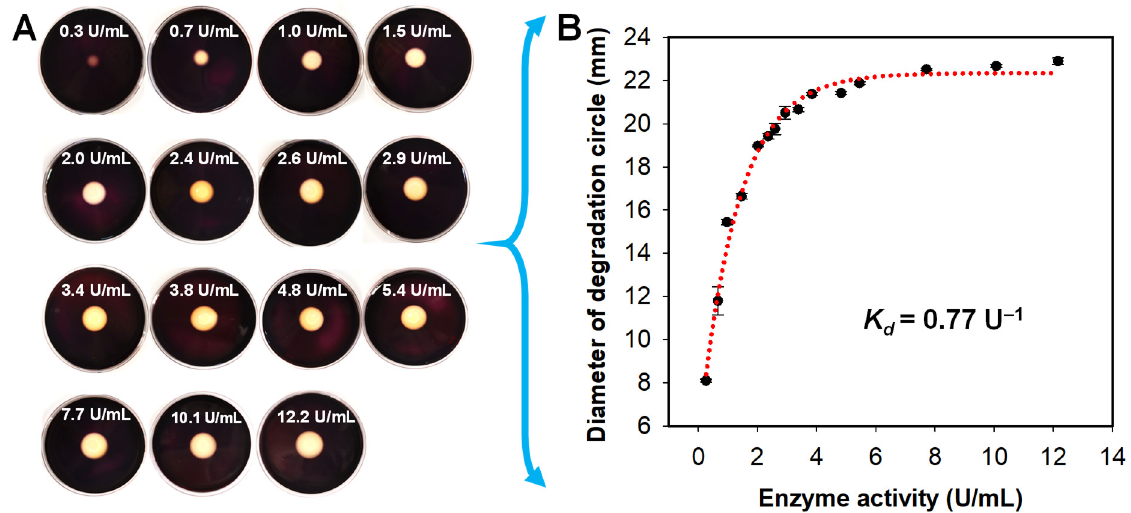
Figure 4. The agar-degrading capacities of agarase secreted by A. macleodii QZ9-9. ( A ) Characteriza- tion of agar-degrading activity of crude agarase with different enzyme activities on the mineral salts agar plates (stained with Lugol’s iodine solution). ( B ) Kinetics of agar degradation by agarase. Note: The data were fitted according to the first-order rate equation Y EA = Y 0 + a(1 − e − kx ), where Y EA and Y 0 are the degradation fraction at a given enzyme activity EA and 0 U/mL, respectively; a is the fitting coefficients; and k is the observed rate constant.